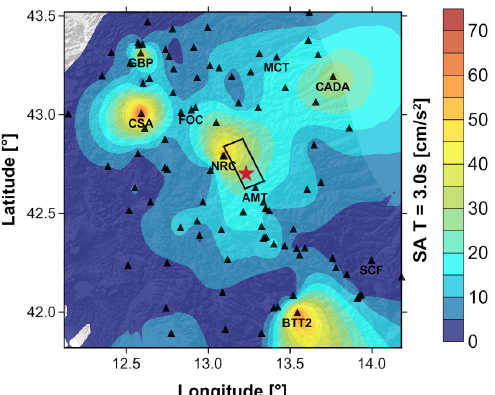
Figure 5 . Map of interpolated horizontal spectral acceleration (T =